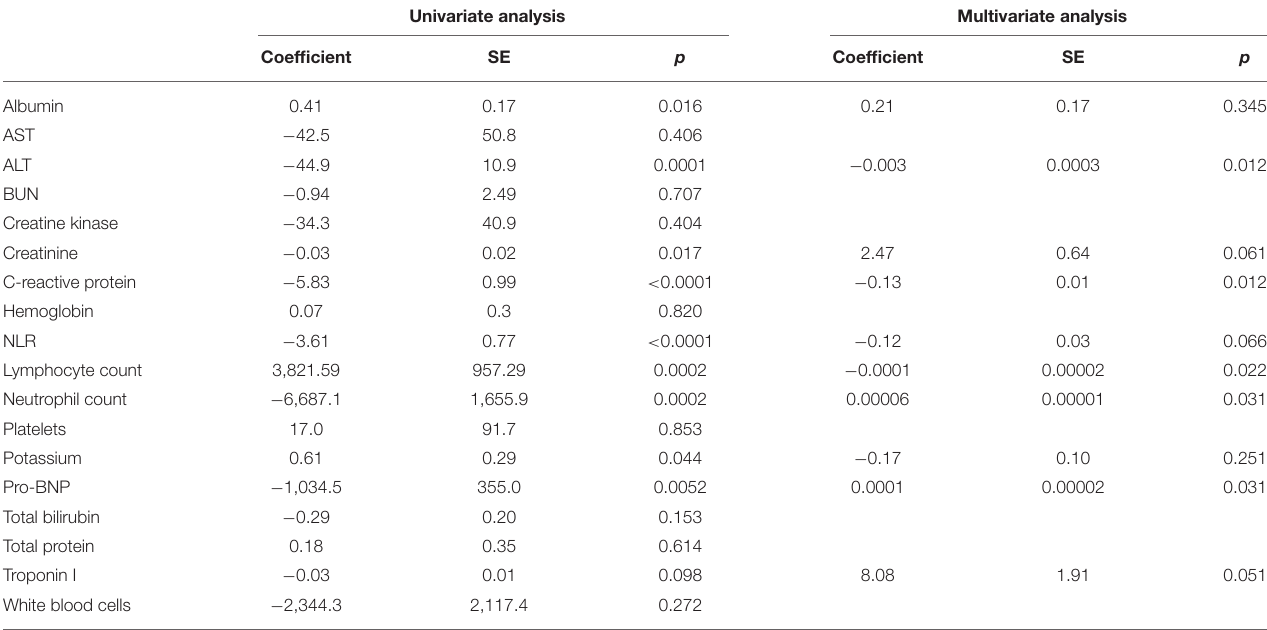
TABLE 3 | Results of univariate and multivariate regression analyses of CD56 − CD16 + NK cells: correlations with laboratory findings in IVIG-resistant patients. Univariate analysis